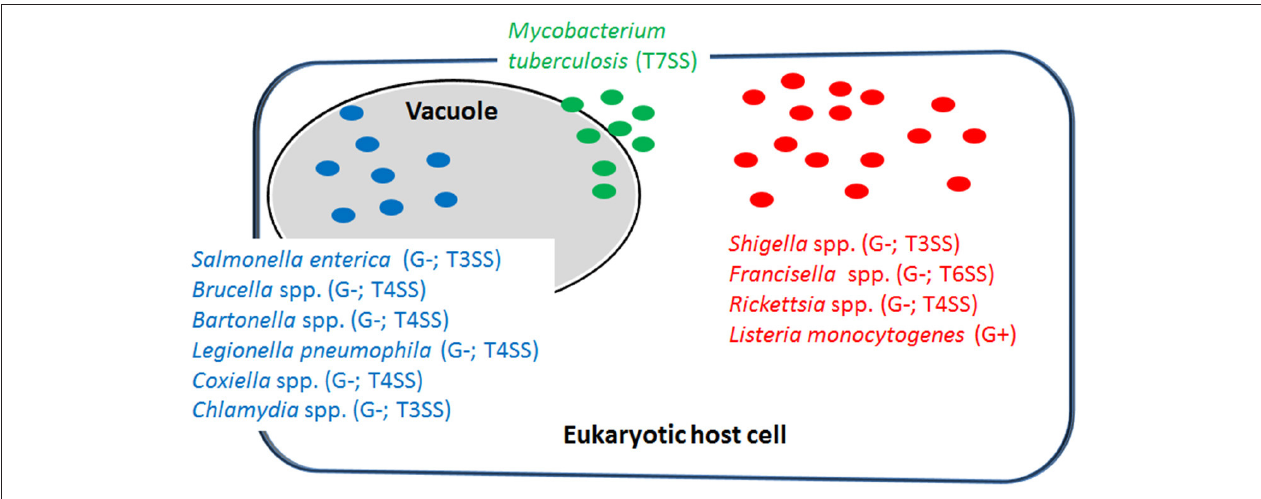
FIGURE 1 | Representative examples of intracellular bacterial pathogens (IBPs; mentioned in this review) replicating in specialized vacuoles (in blue) or in the host cell’s cytosol (in red). Some IBPs (e.g., M. tuberculosis ) are able to replicate in both cellular compartments (in green). G − , Gram-negative; G + , Gram-positive; T3SS, type 3-secretion system; T4SS, type 4-secretion system; T6SS, type 6-secretion system; T7SS, type 7-secretion system.